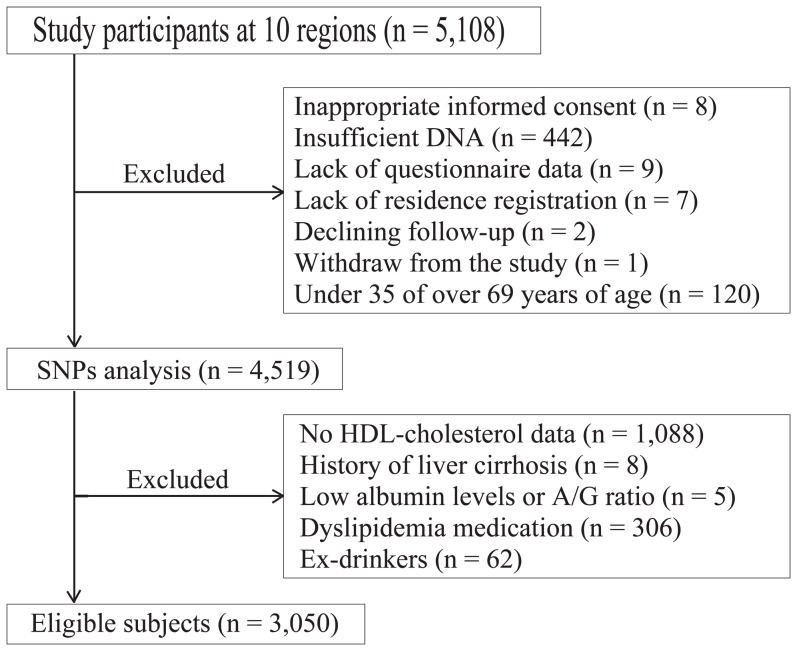
Diagram to list individuals who were excluded from the study sample.